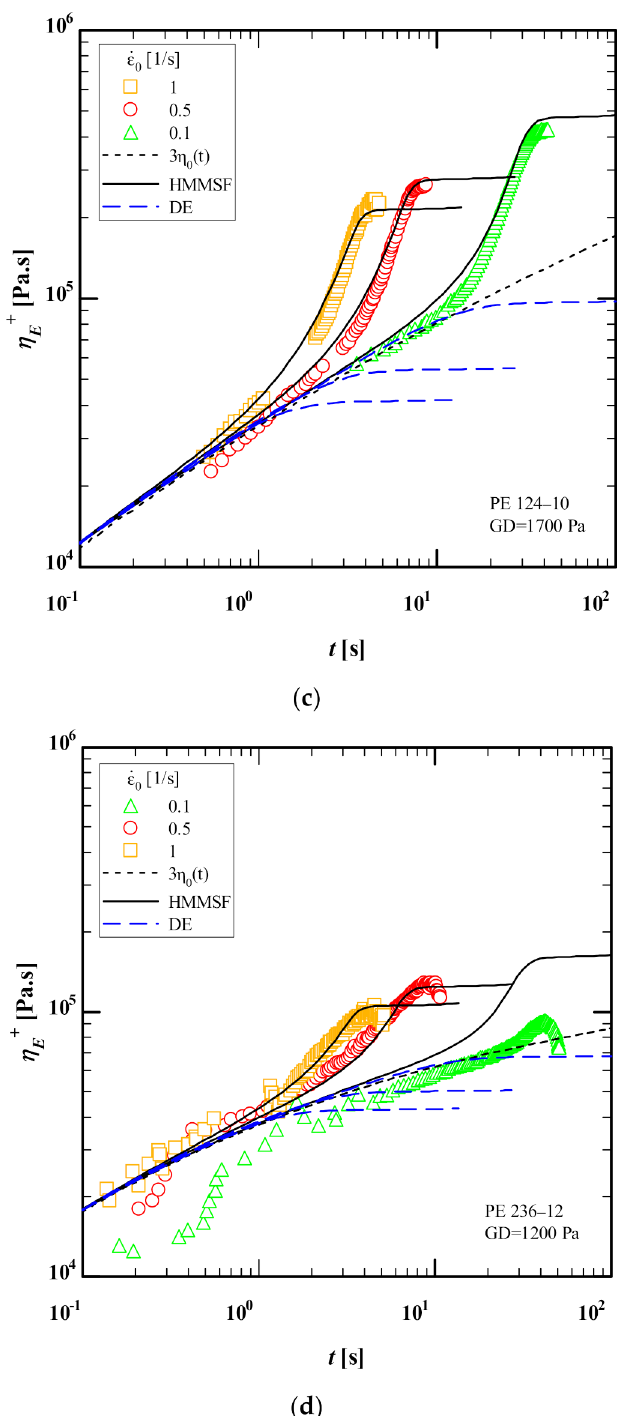
Figure 4. Comparison between data (symbols) of the extensional stress growth coefficient as a function of time of ( a ) PE 191-8, ( b ) PE 127-9, ( c ) PE 124-10 and ( d ) PE 236-12 at 150 ◦ C with predic- tions of the Doi-Edwards (DE) model (blue dash lines) and the HMMSF model (Equations (4)–(6)) (continuous black lines) using the IRIS software